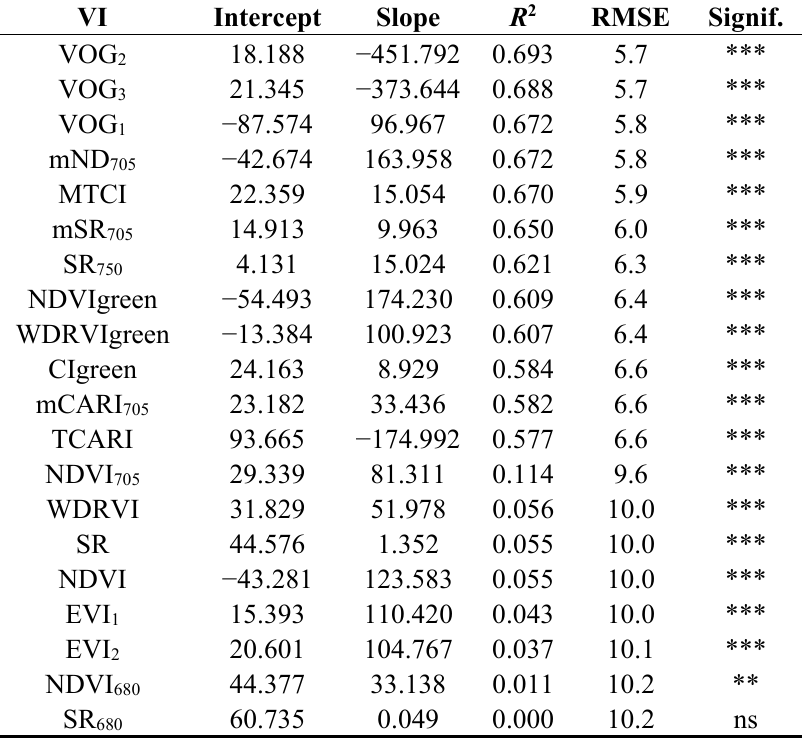
Table 3. Relationship between CC and VIs for R. mangle ( n = 579). VI